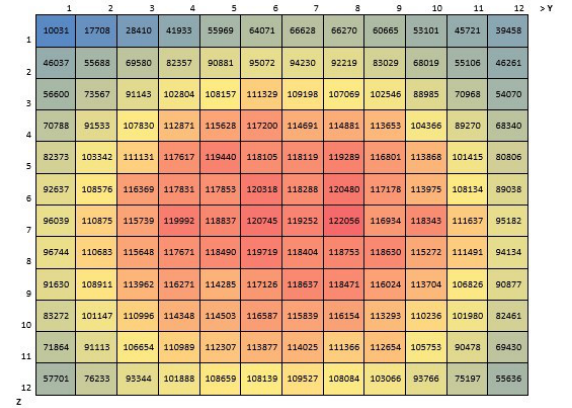
Figure 7. The map of neutron flux distribution.